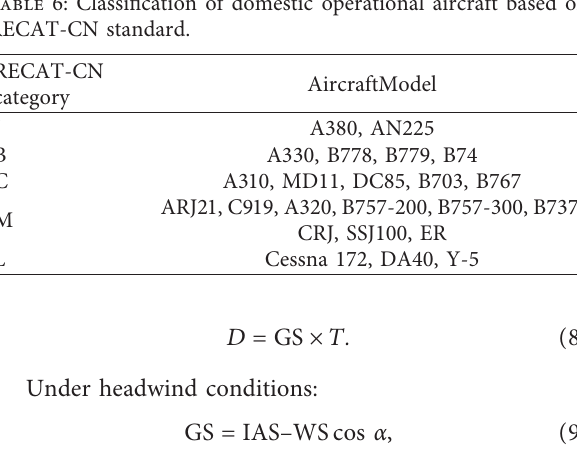
Table 6: Classification of domestic operational aircraft based